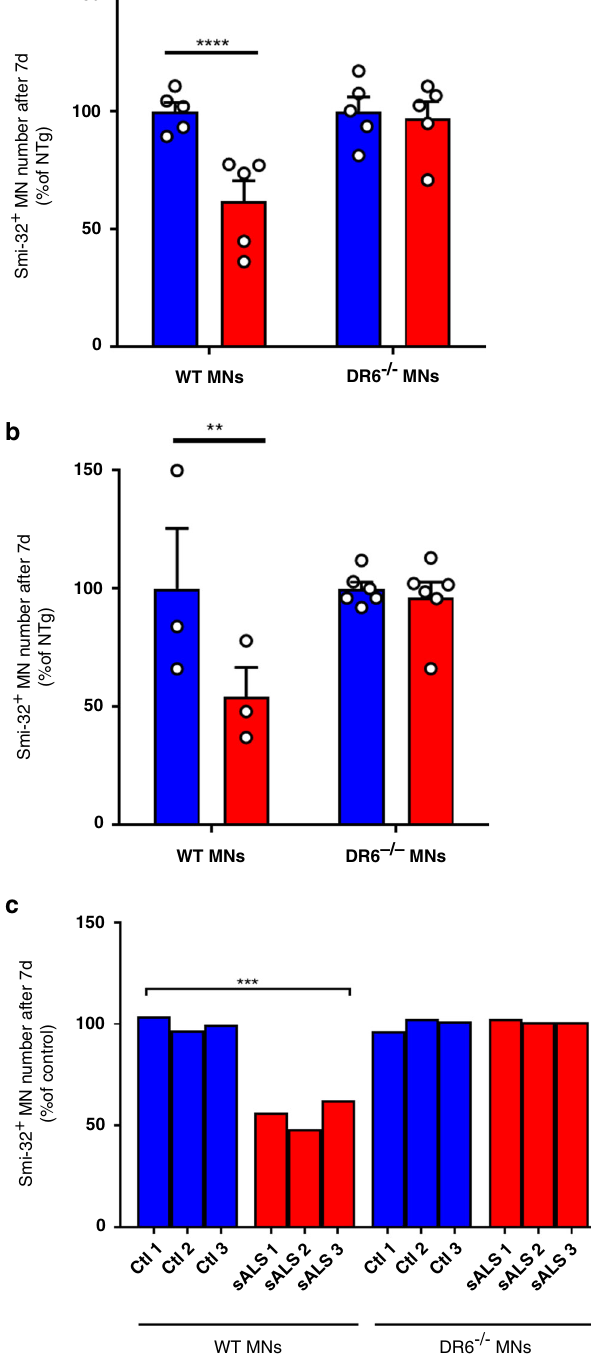
Fig. 4 mutSOD1 and sALS astrocytes mediate MN death via a DR6- dependent mechanism. a Co-culture of mouse WT or DR6 − / − MNs with astrocytes from NTg (blue, n = 5) or mutSOD1 (red, n = 5) mice. Data are means ±SEM of independent experiments ( n ) analyzed by two-way ANOVA (Interaction F (1,16) = 6.903; P = 0.0183) followed by Sidak post hoc test: ** P = 0.0020 WT neurons/NTg AML vs WT neurons/mutSOD1 AML (CI: 14.69 – 61.54%; d = 4.94). b WT ( n = 3) or DR6 − / − MNs ( n = 6) were cultured in the presence of ACM from astrocytes from NTg (blue) or Tg mutSOD1 (red) mice. Data are means ±SEM of independent experiments ( n ) analyzed by repeated measures two-way ANOVA (Interaction F (1,7) = 12.68; P = 0.0092) followed by Sidak post hoc test: ** P = 0.0042 WT neurons with NTg ACM vs mutSOD1 ACM (CI: 18.35 – 72.99%; d = 1.61). c Astrocytes from three independent human controls or three sALS patients were co- cultured with either WT or DR6 − / − MNs. The cells were then fi xed and imaged using the neuronal marker SMI-32 a – c and counted. Individual data points are plotted and data were analyzed using two-tailed Student ’ s t test: WT Control vs sALS astrocytes ( t (10) = 5.943, *** P = 0.0001; CI: − 61.87% to − 28.13%; d = 3.19). See also Supplementary Figs. 4 and 5. Source